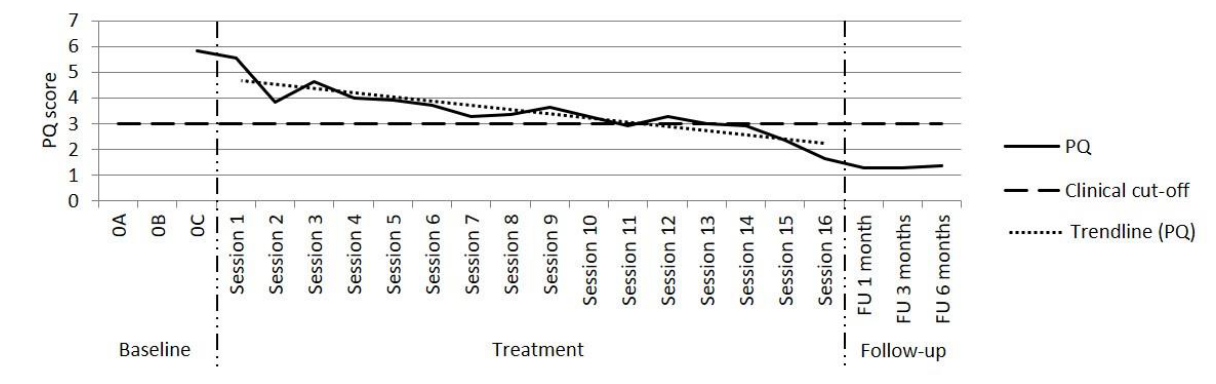
Figure 3: Giorgio’s weekly personal problems (PQ)